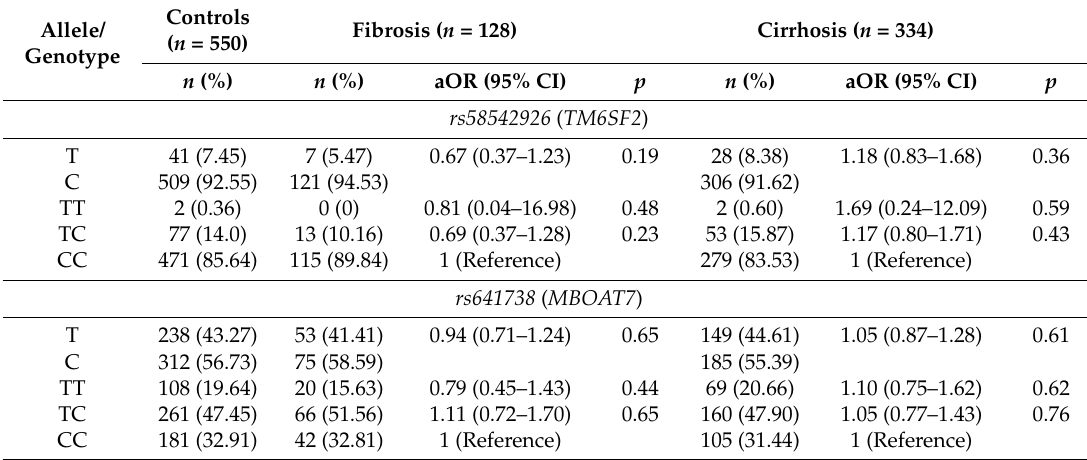
Table 2. Distribution of the TMS6SF2 and MBOAT7 SNPs alleles and genotypes in liver fibrosis and cirrhosis groups.